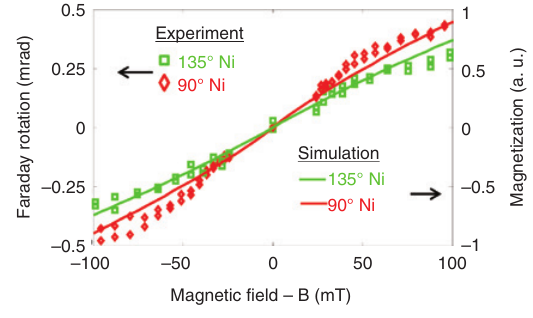
Figure 5: Hysteresis in bimetallic ring resonators. Simulated (solid lines) and experimentally measured (markers) hys- teresis in bimetallic rings with 90 ° (red) and 135 ° (green) Ni sector. Simulated data correspond to the magnetization of the system, while experimental results are presented in the form of Faraday rota- tion, which is proportional to the